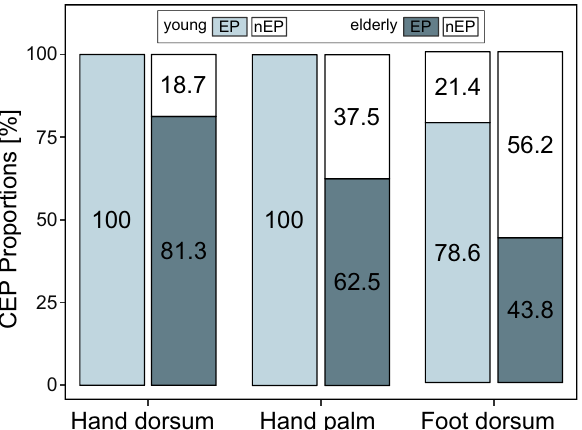
Figure 1. CEP proportions. Percent of present (EP) and absent (nEP) CEPs after stimulation of the hand dorsum, hand palm, and foot dorsum for the young and elderly age